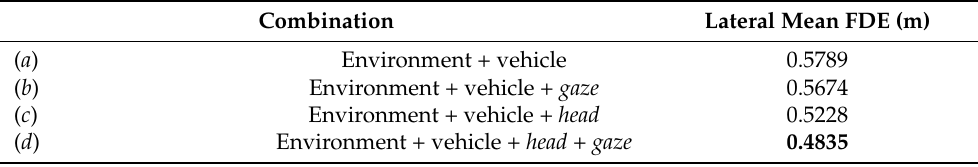
Table 2. Lateral mean FDE of different combinations of features.